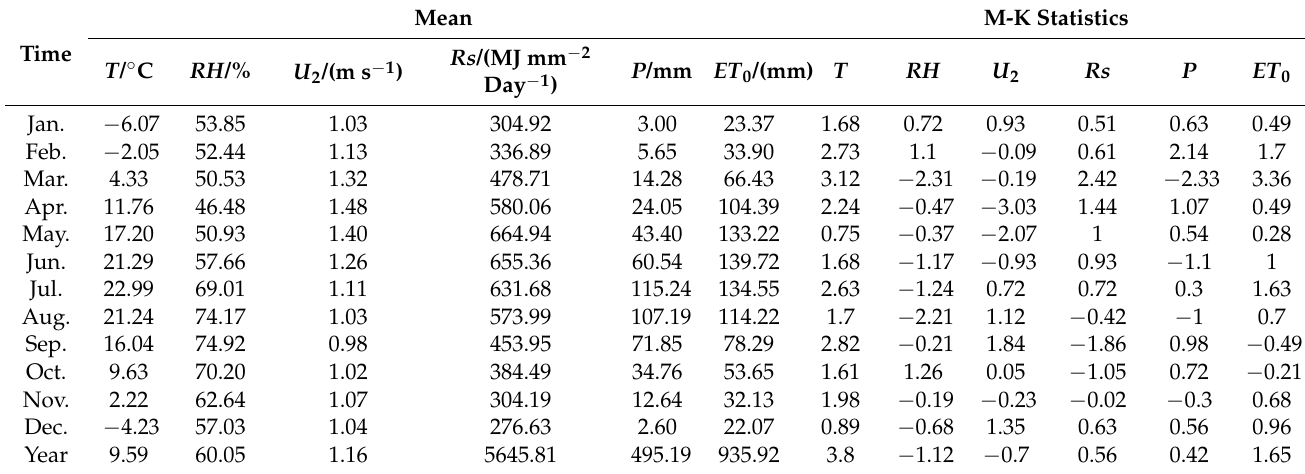
Table 1. Temporal characteristics of ET 0 and meteorological factors in Yanhe River